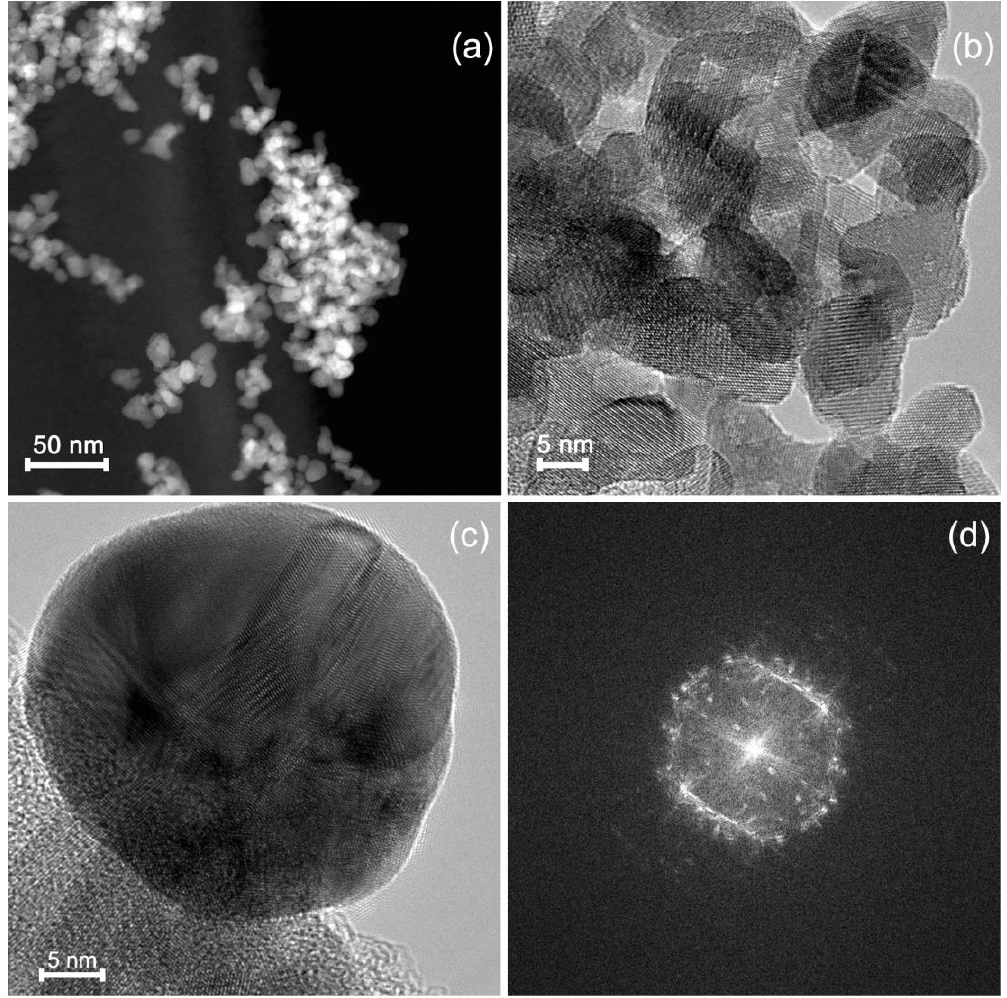
Figure 4. ( a ) High angle annular dark field scanning transmission electron microscopy (HAADF-STEM) and ( b ) high resolution transmission electron microscopy (HRTEM) images of In 2 O 3 /Ag-imp nanocomposite; ( c ) TEM image of a Ag nanoparticle in In 2 O 3 /Ag-imp nanocomposite and ( d ) Fourier transform proving its polycrystallinity.